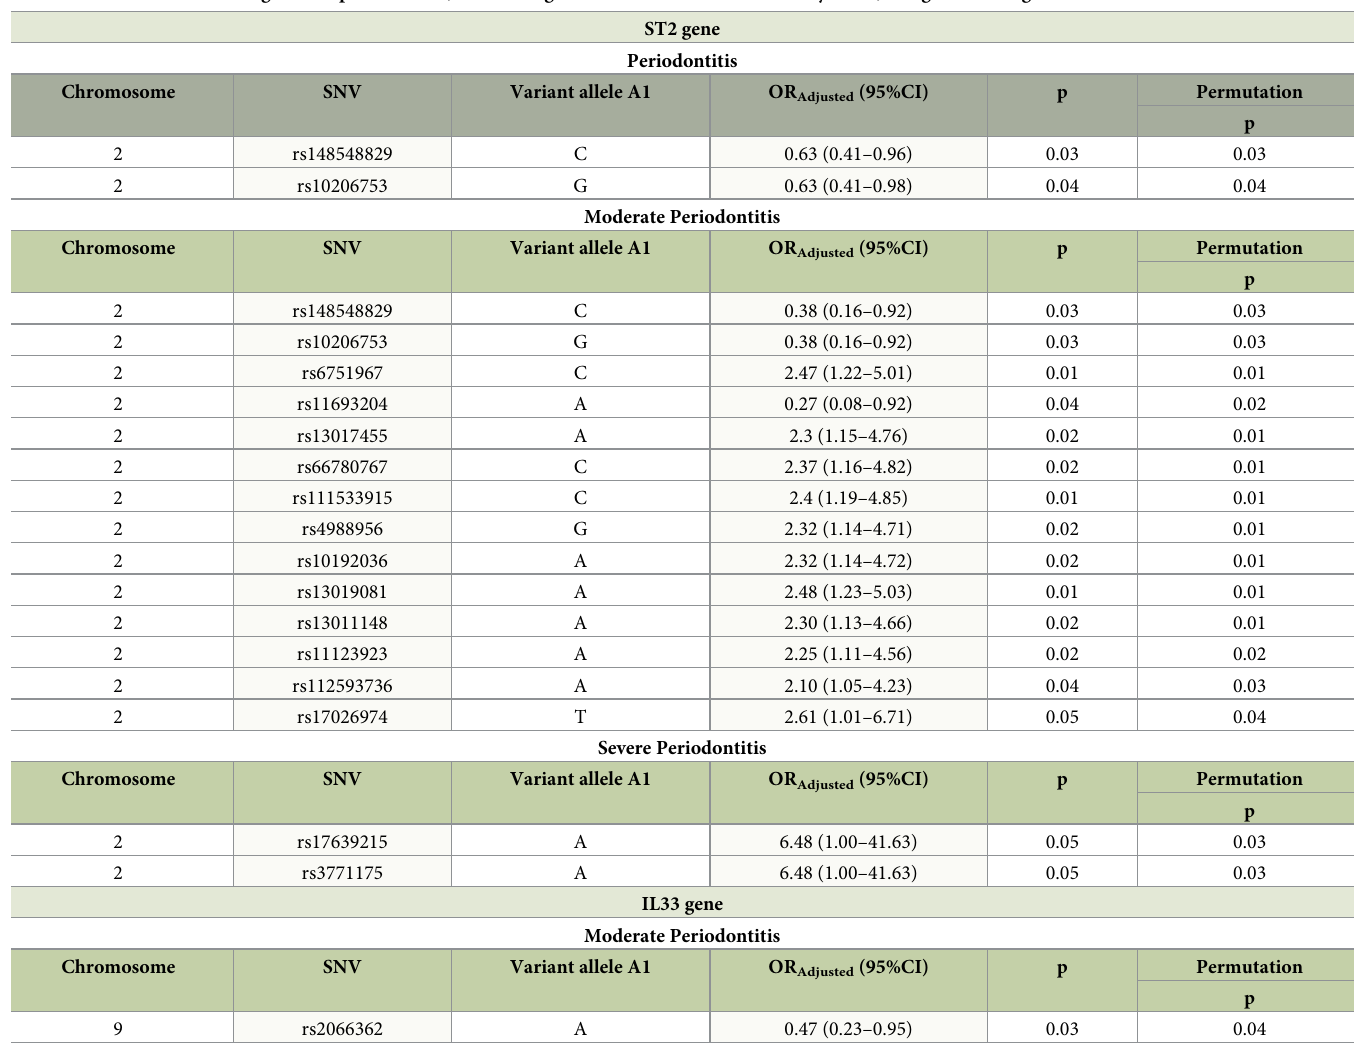
Table 2. Statistically significant adjusted association measurements, odds ratio and 95% confidence interval, between the SNVs of the IL-33 gene and periodontitis, as well as the SNVs of the ST2 gene and periodontitis, considering the severe and moderate severity levels, using dominant genetic